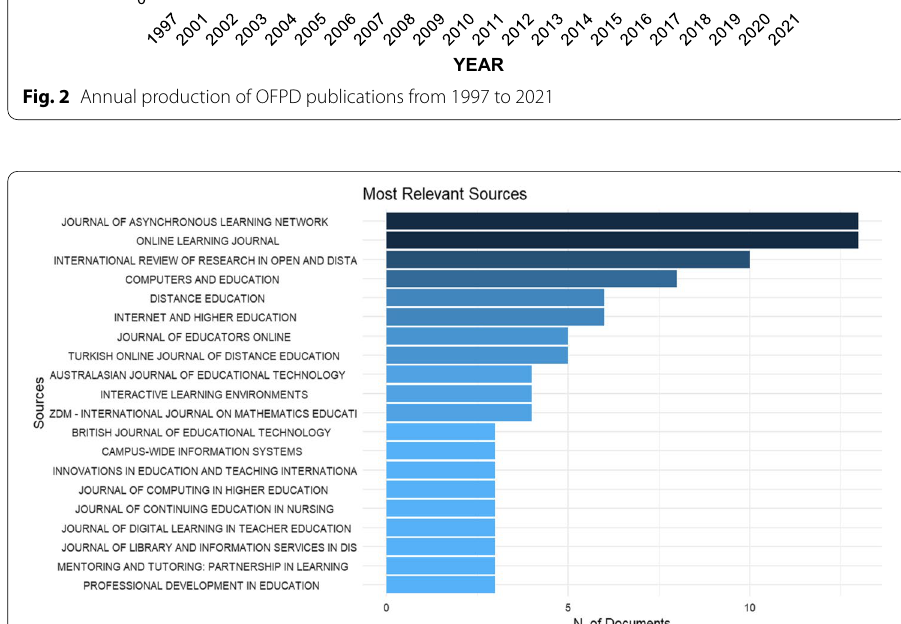
Fig. 3 Most relevant sources for OFPD in terms of number of